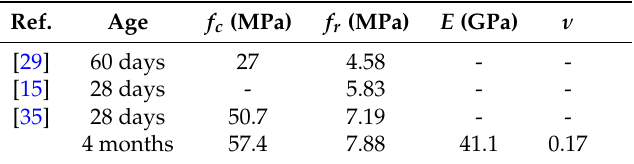
Table 3. Fitted model parameters for flexural fatigue tests of plain concrete carried out by Oh [29], Shi et al. [15] and Zhang et al. [35], as well as the testing conditions. Ref.